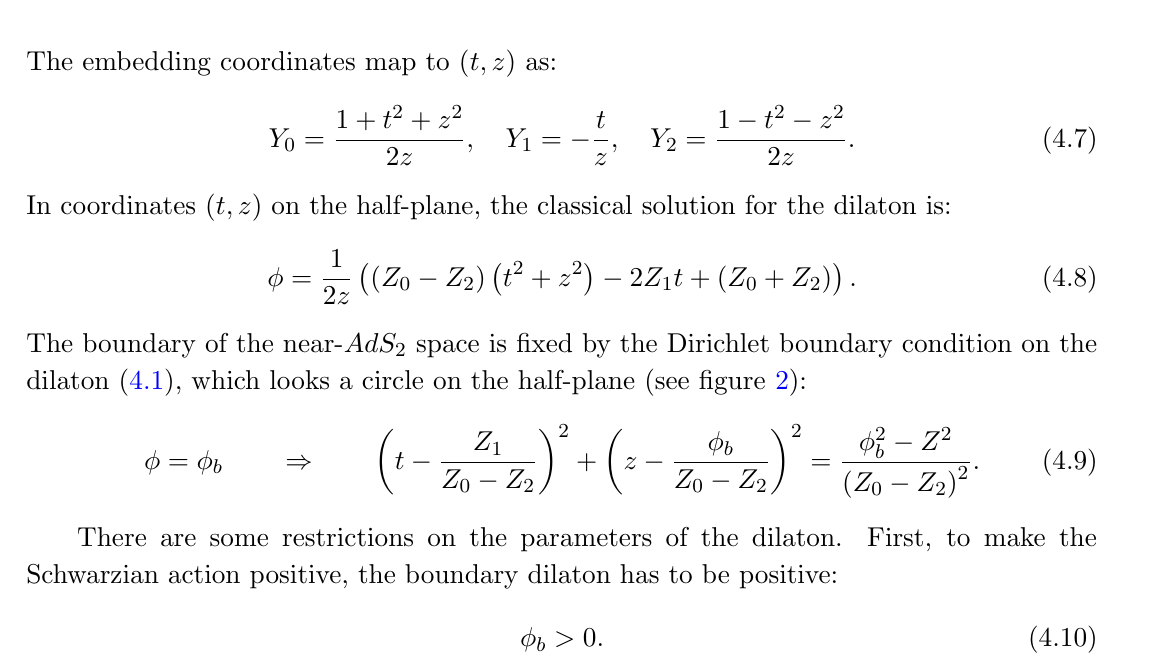
Figure 2 . When mass is small, the NAdS boundary is a perfect